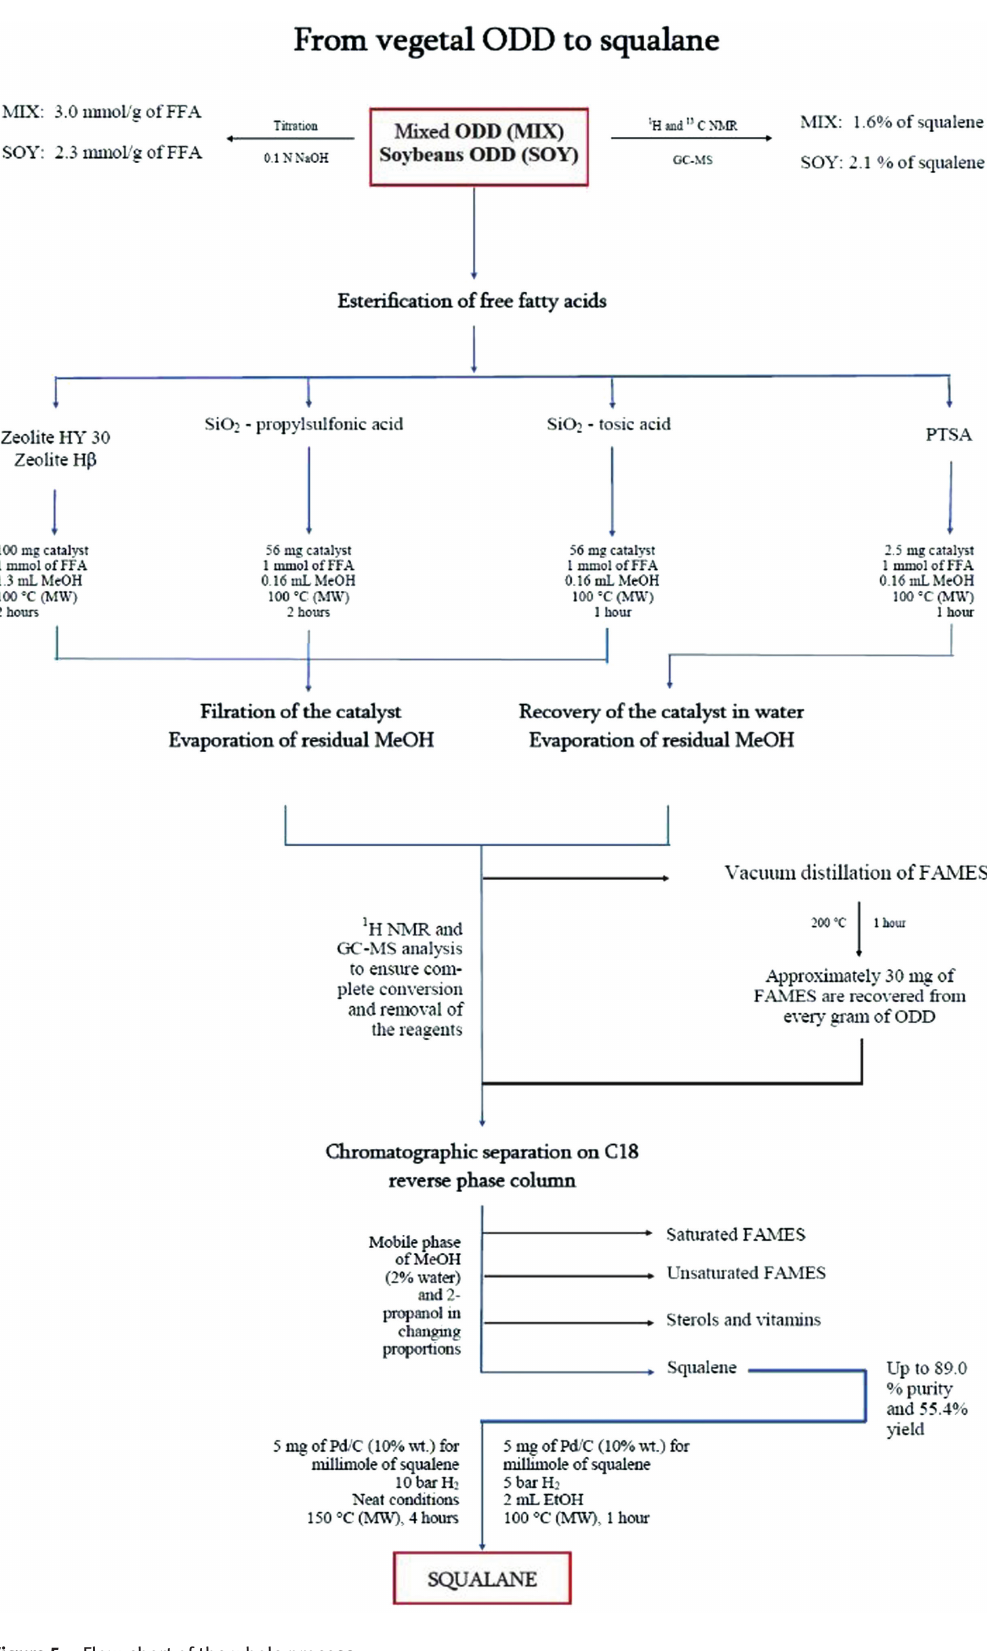
Figure 5: Flow-chart of the whole